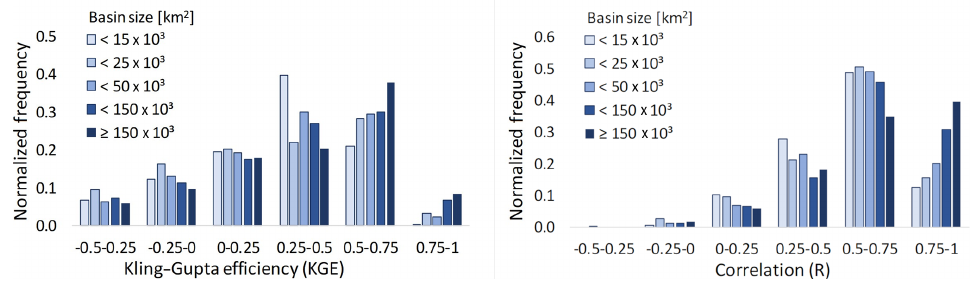
Figure 4. Histograms of Kling–Gupta efficiency and correlation for different basin sizes based on 1366 GRDC stations.